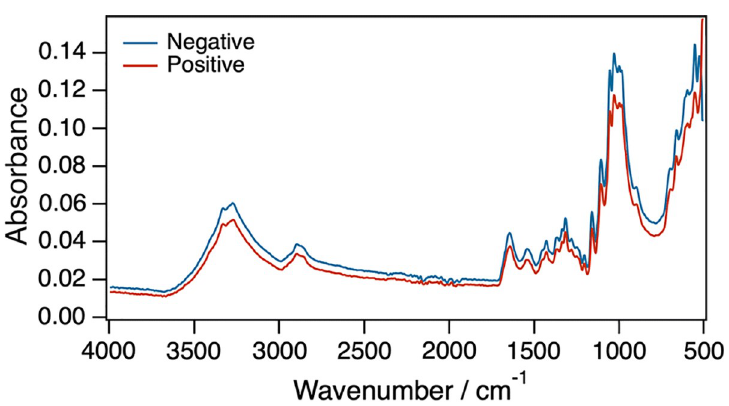
Fig 2. An example of an averaged MIRS spectra from dried blood infected with malaria parasites (red spectrum) and uninfected blood (blue spectrum). Adapted from Mwanga and colleagues [70].